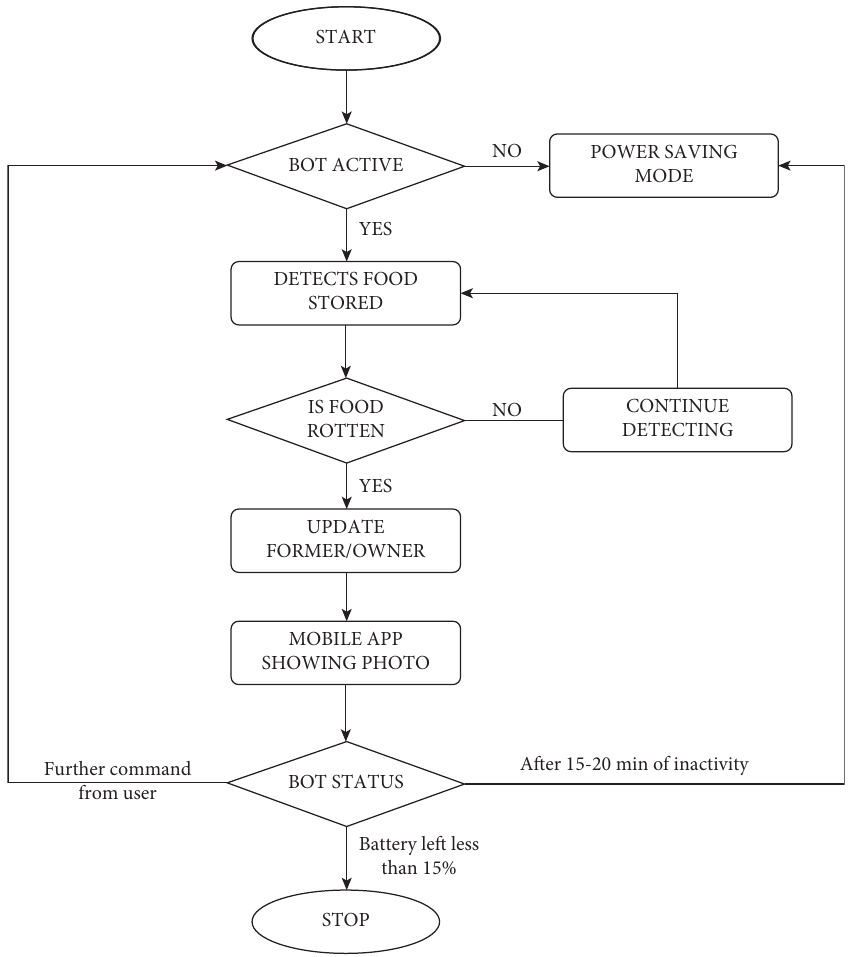
Figure 9: Flowchart of food safety using a